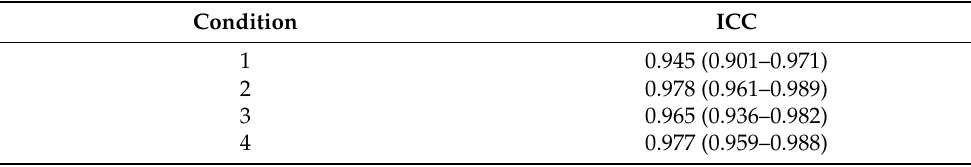
Table 3. Intra-rater reliability of L Test in people with stroke.